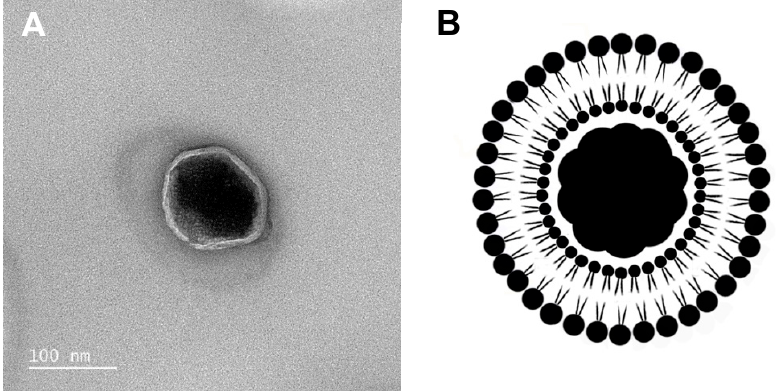
Figure 10. ( A ): HR-TEM image of a solid magnetoliposome based on Ca 0.25 Mg 0.75 Fe 2 O 4 ferrite nanoparticles. ( B ): Schematic representation of a SML, characterized by the presence of a core (cluster of magnetic nanoparticles) covered with a lipid bilayer.